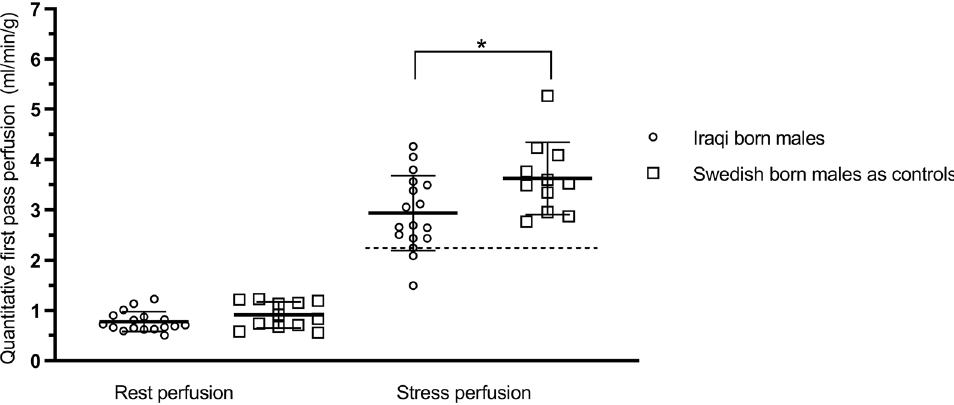
Figure 3. Global quantitative first pass perfusion in Iraqi versus Swedish born males at rest and during adenosine. Perfusion during adenosine was significantly lower in Iraqi males but there was no difference in myocardial perfusion at rest. If a cutoff 2.25 ml/min/g for a decreased absolute perfusion is used (dashed horizontal line) three Iraqi subjects demonstrate signs of microvascular disease. Error bars denote mean ±